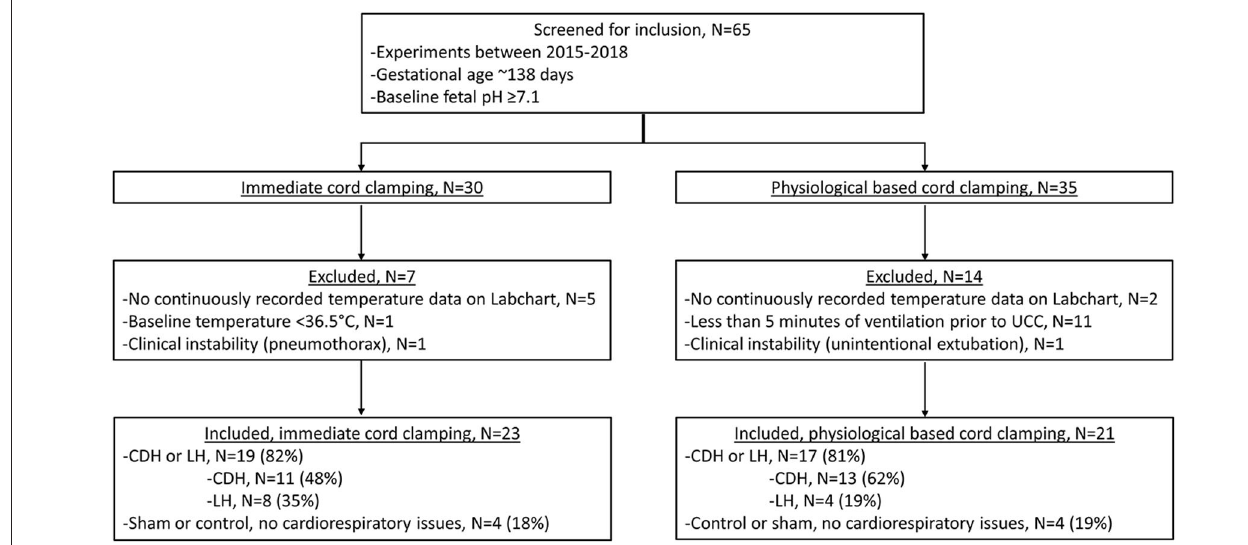
FIGURE 1 | Criteria for inclusion and exclusion, CDH, congenital diaphragmatic hernia; LH, lung hypoplasia.